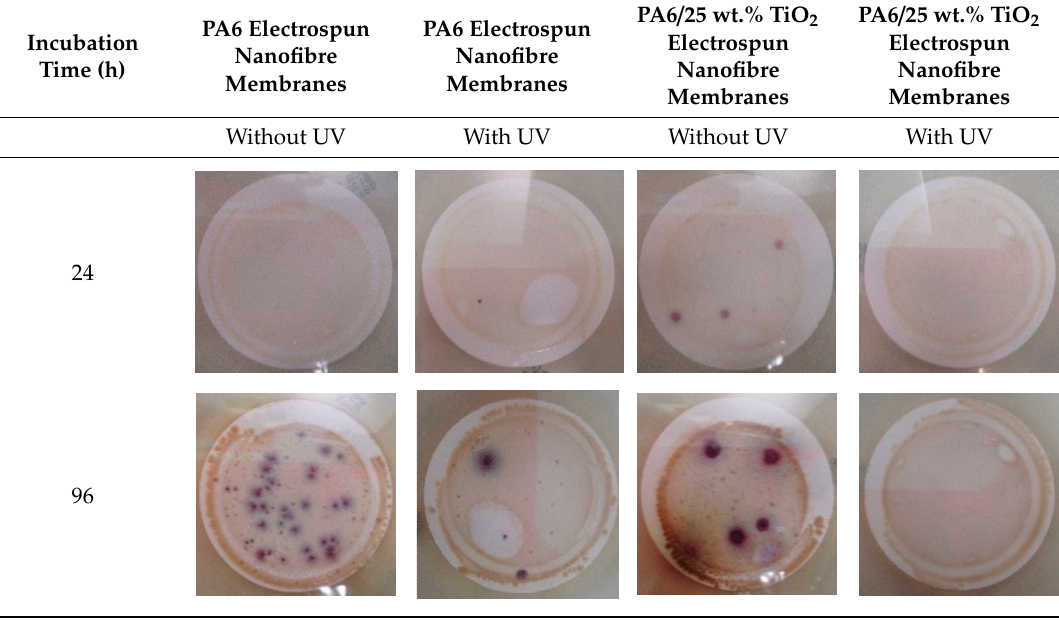
Table 2. Photographs of the filters after 24 h or 4 days of incubation at 36 ± 2 ◦